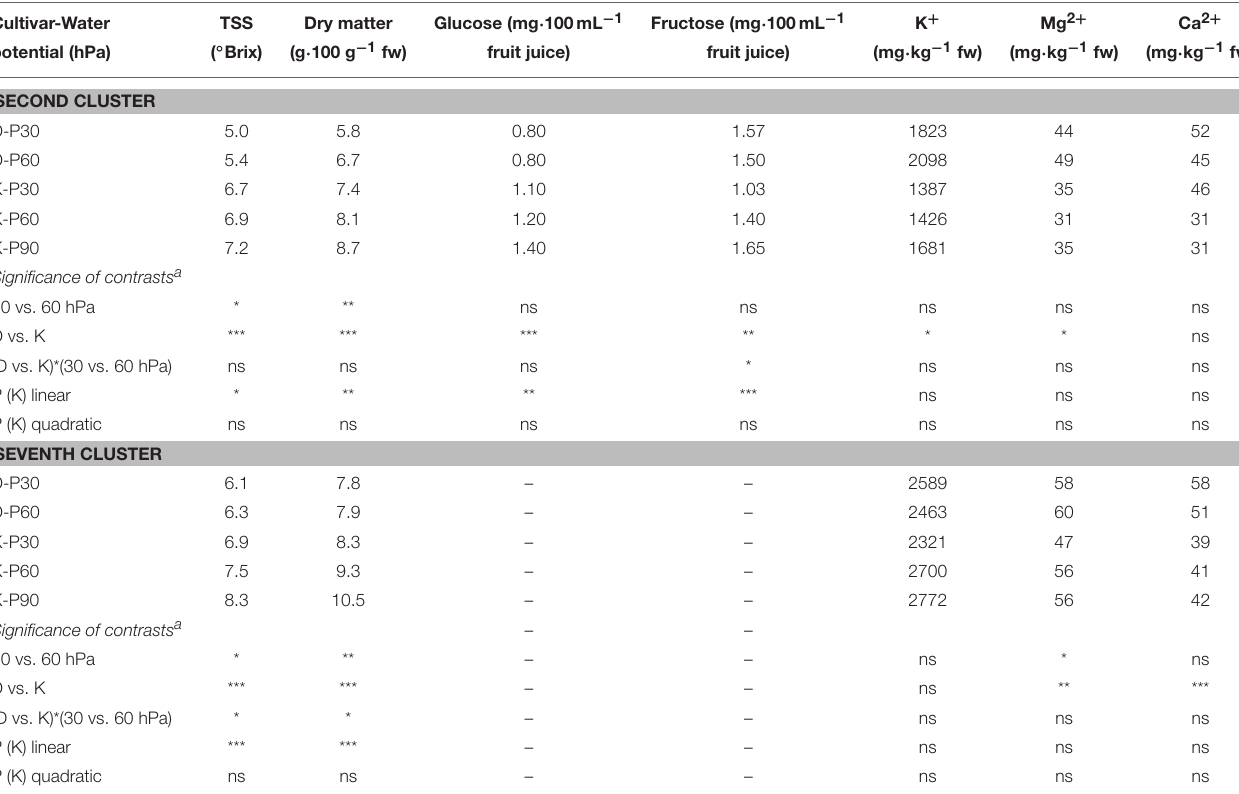
TABLE 3 | Effect of cultivar (Diana—D and Kabiria—K) and growing-media matric potential (P) on total soluble solids (TSS), fruit dry matter, glucose, fructose, K, Mg, and Ca fruit concentration in the second and seventh cluster of subirrigated soilless tomato under controlled water stress conditions.